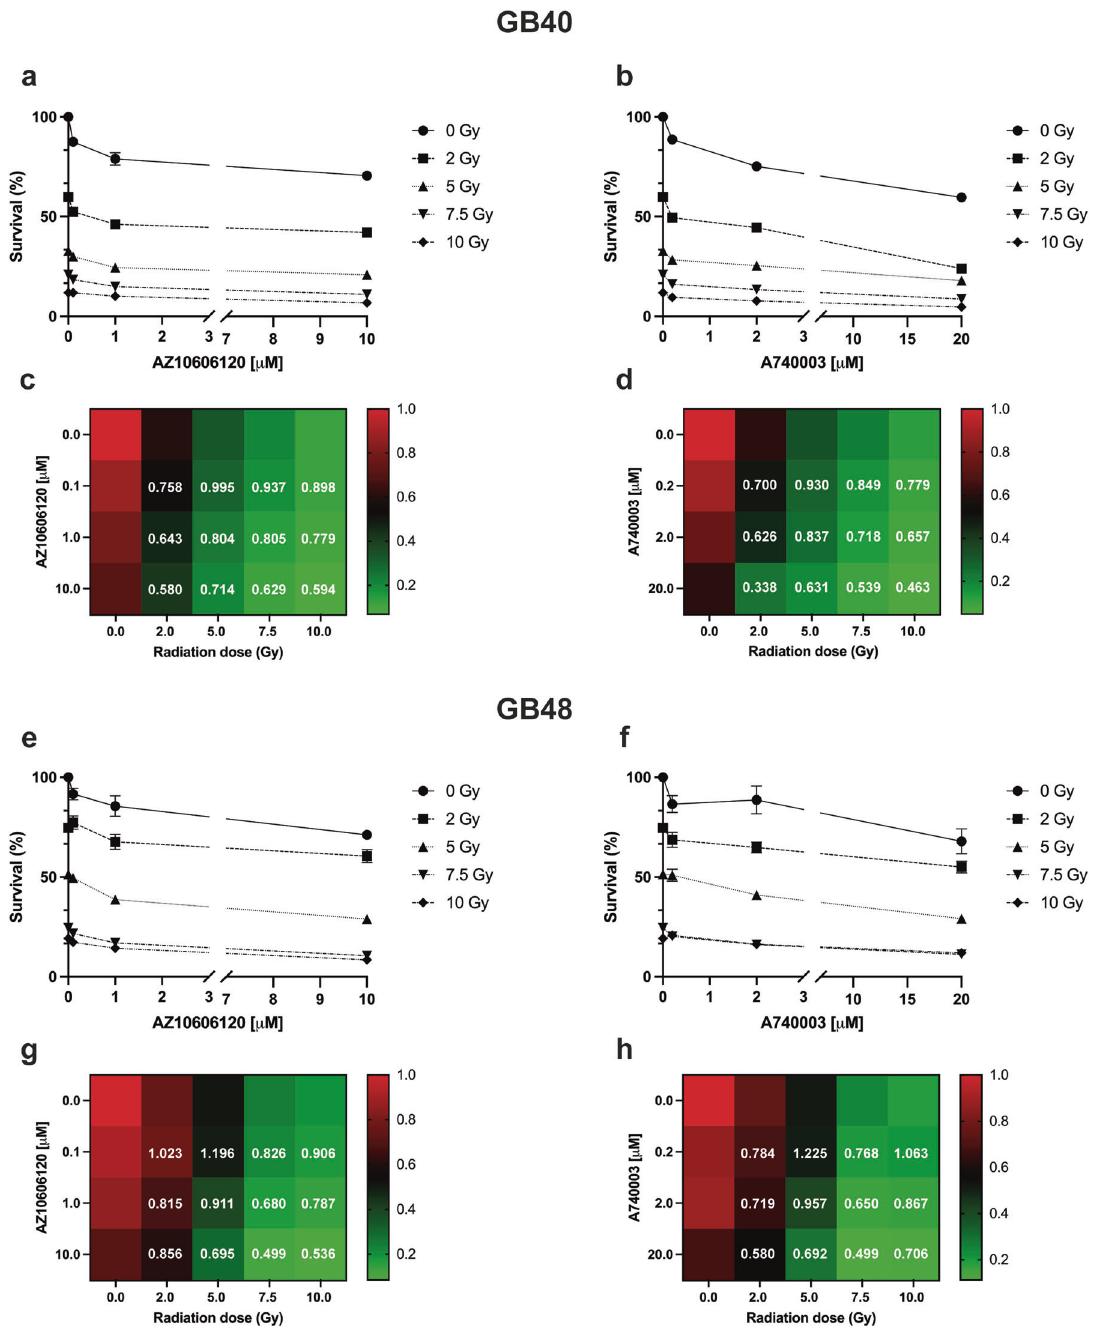
Fig. 7 P2X7R antagonist ’ s treatment potentiates irradiation cytotoxic effects in GBM. Percentage of surviving cells measured by soft agar assay at 28 days from radiation treatment in the absence or presence of P2X7R blockade with AZ10606120 or A740003 in GB40 ( a , b ) and GB48 ( e , f ). Data are shown as the mean ± SEM; n = 6. Heatmap shows the number of colonies (survival fraction) measured by soft agar assay at 28 days from radiation treatment in the absence or presence of P2X7R blockade in GB40 ( c , d ) and GB48 ( g, h ). Data were shown as the mean; n = 6. Combination index (CI) analysis of GB40 and GB48 cells treated with increasing concentrations of irradiation, AZ10606120 and A740003 are reported in white. The additive, synergistic, and antagonistic effect of the combinations was calculated using Compusyn Software (CI <1 synergism; CI = 1 additivity; CI >1 concentrations precipitates cell death, stimulation with low doses GB48 cells. P2X7A expression followed a quite different, and promotes survival. There is ample in vivo evidence showing that opposite time course, being almost abrogated at those time P2X7R pharmacological blockade inhibits tumor progression. points (e.g., p.i. days 14 or 21) where β -gal positive cells, tail DNA Irradiation causes a large eATP release, thus we wondered accumulation, cholesterol level, and P2X7B expression were whether P2X7R blockade during p.i. recovery would reduce or maximal (Fig. 6e, f). rather increase radiation-induced GBM death. As shown in Fig. 7, The P2X7R has often been dubbed a dual-function (or Dr. Jekyll/ treatment with two different P2X7R antagonists (AZ10606120 and Mr. Hyde) receptor [53] as while stimulation with high eATP